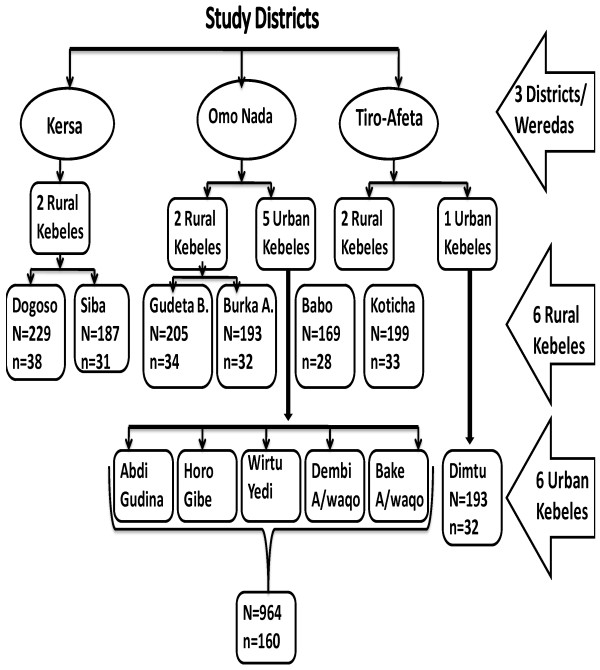
Flow chart indicating the sampling procedure. Where: N= the number of pregnant women in given rural Kebeles or urban Kebeles n= number of pregnant women sampled from rural Kebeles or urban Kebeles.